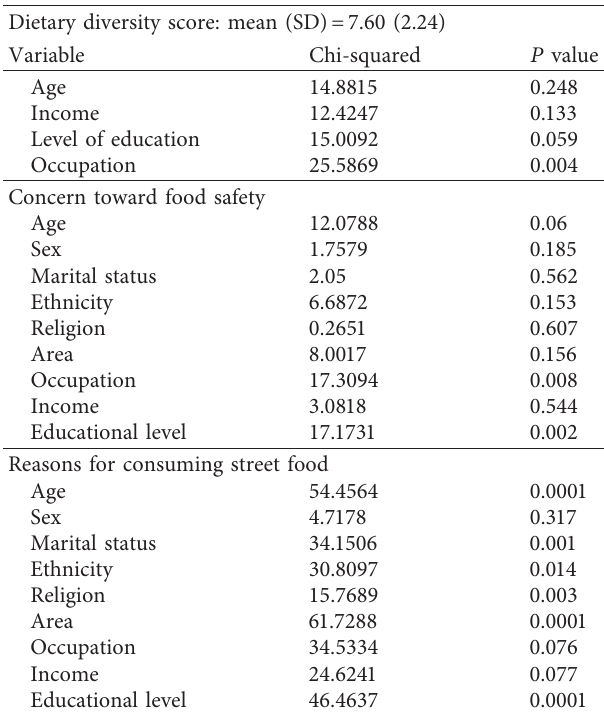
Figure 2: Reasons for consuming street foods. Table 3: Relationship between various demographic variables and the dietary diversity score concern toward food safety, as well as reasons for consuming street